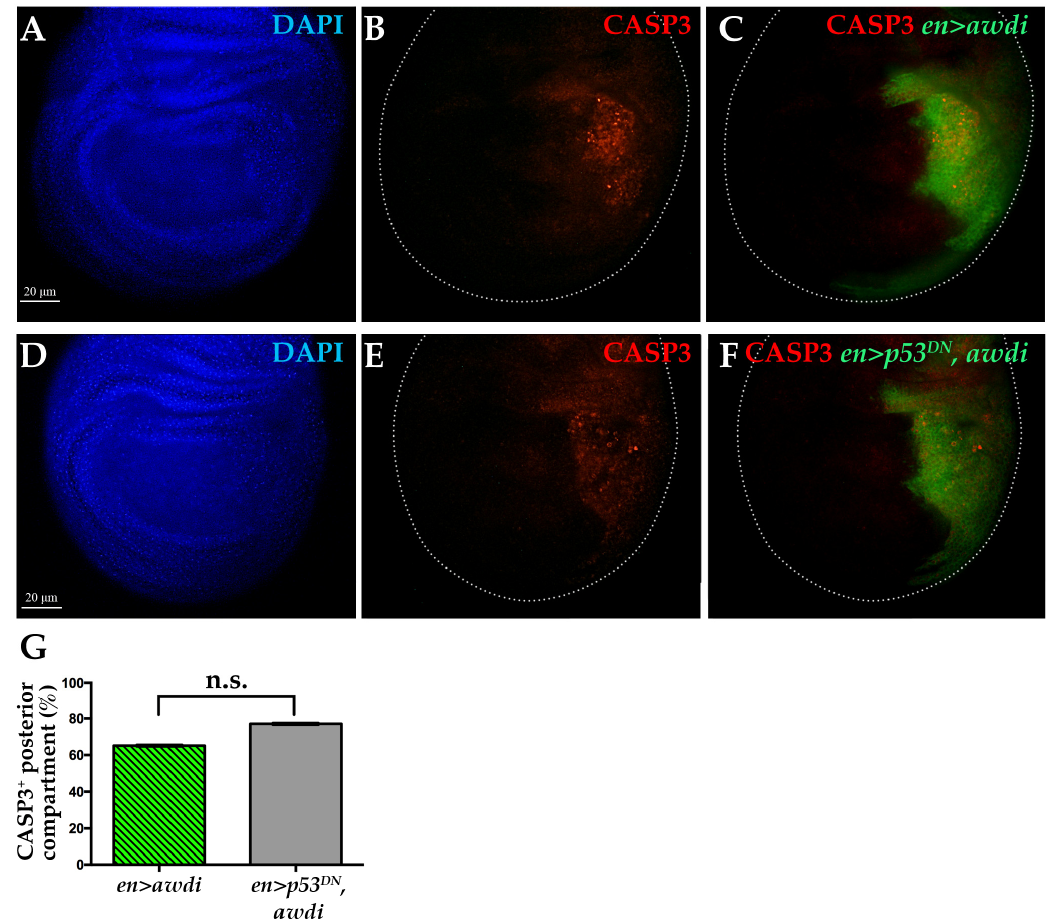
Figure 3. Caspase 3 activation following awdi is unaffected by coexpression of p53 DN . Fluorescence microscopy image of wing disc dissected from en > awdi ( A – C ) and en > p53 DN , awdi ( D – F ) larvae. Wing discs are labelled by DAPI ( A , D ), anti-activated Casp3 ( B , C , E , F ) and GFP ( C – F ). White dots outline wing discs. Quantification of the CASP3-positive wing discs ( G ). The graphs represent the mean ± SD; n.s.: not statistically significant.